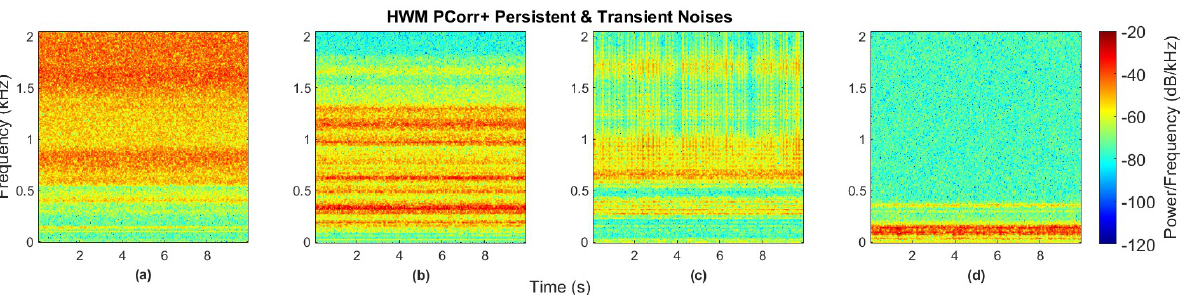
Figure 4. Spectrograms for HWM PCorr+ recordings with persistent leak noises—( a ) hydrant leak, ( b ) service leak; transient and persistent non-leak noises—( c ) water usage noise with meter ticking, ( d ) environmental noises likely from electrical and mechanical sources.